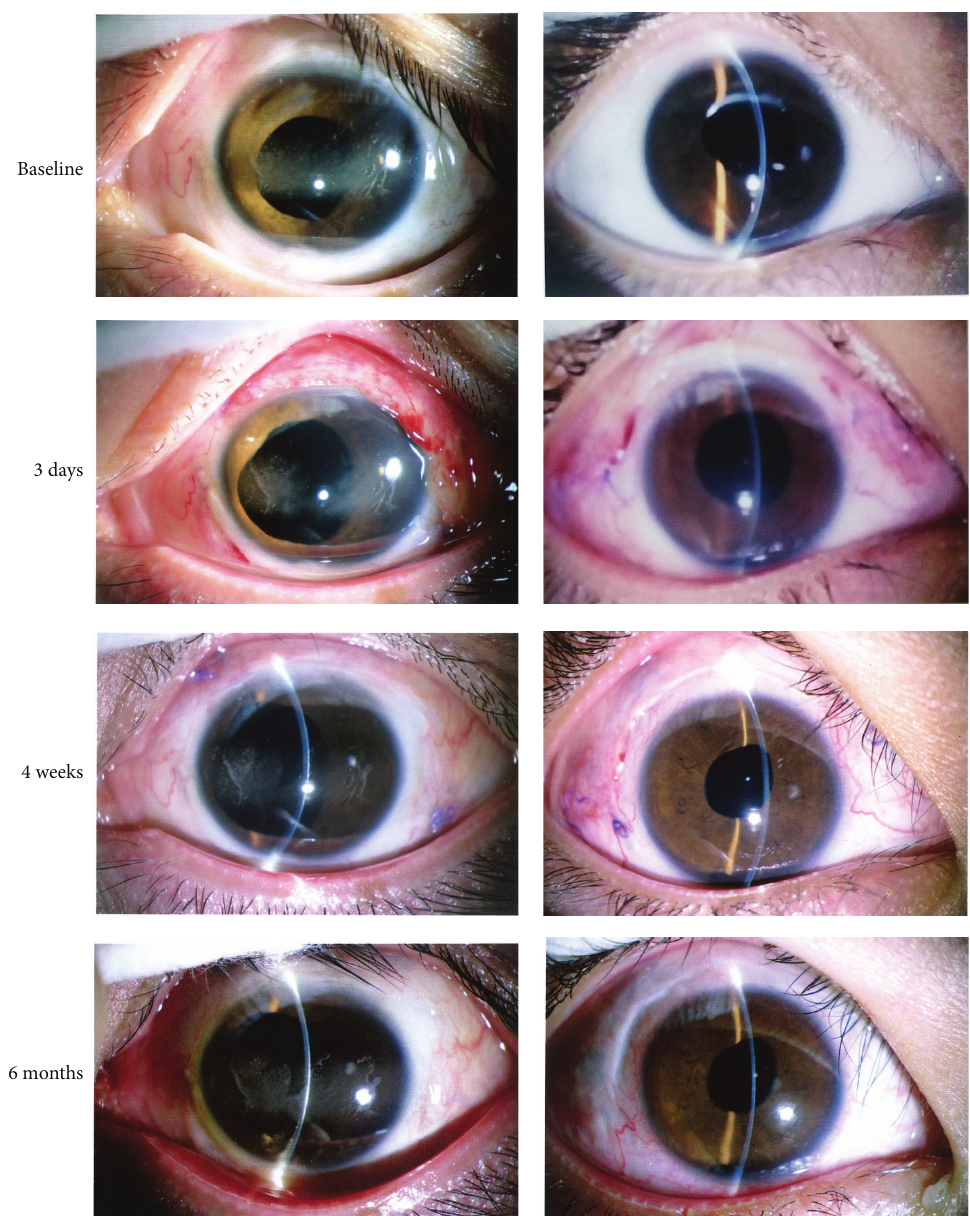
Figure 6: Photographs of ocular anterior segment. Conventional level of inflammation was observed after surgery and resolved in the first 1 or 2 weeks. No obvious inflammation was observed in the cornea or anterior